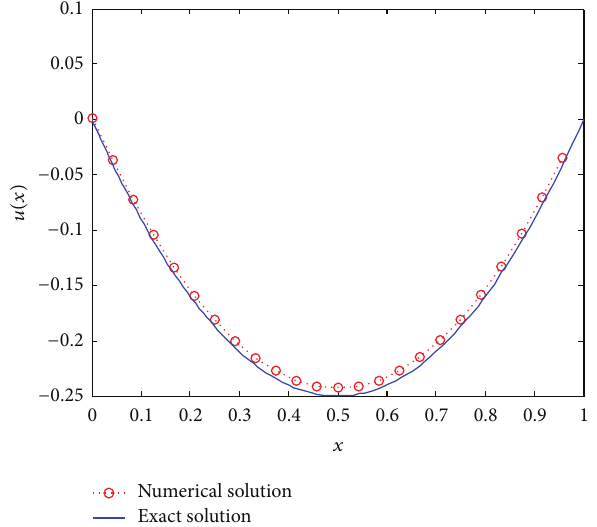
Figure 3: Thecomparison between numerical and exact solutionfor 𝑘 = 3 , 𝑀 = 1 .